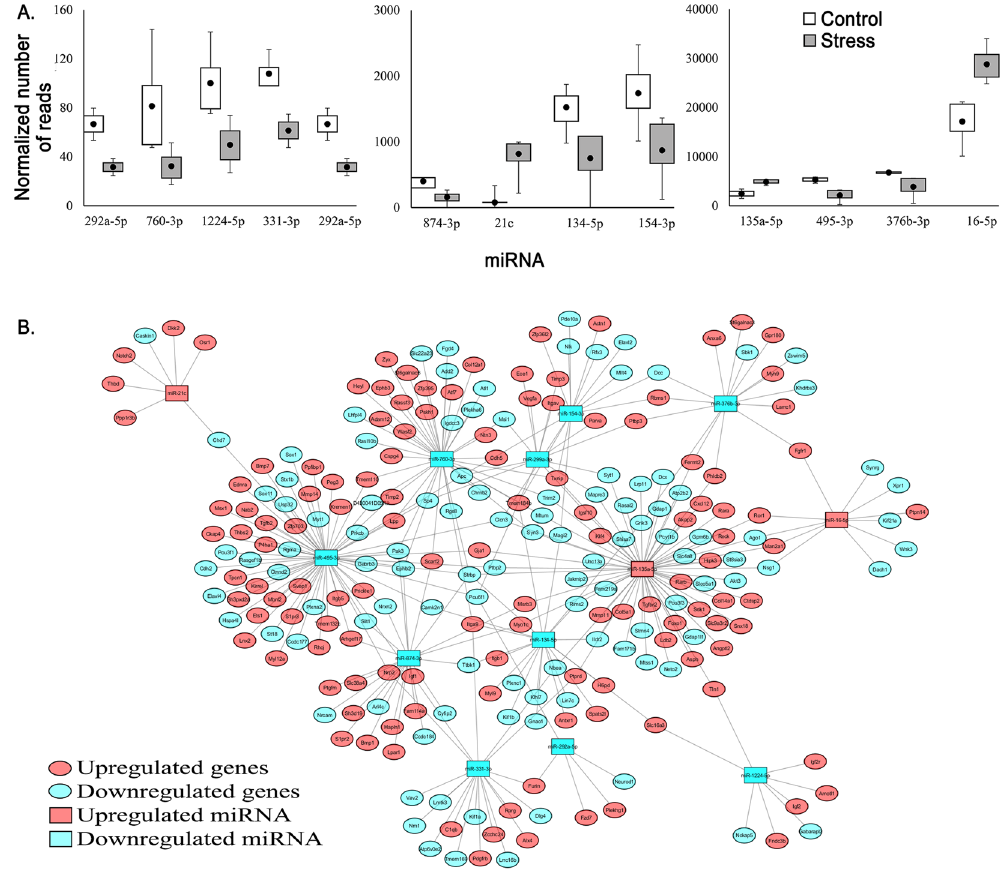
Figure 4. Expression level and targets of differentially expressed (DE) miRNA. ( A ) Number of reads mapping to the 13 DE miRNAs (p ≤ 0.05) that are predicted to target DE mRNA (p ≤ 0.05) in the wild-type (WT) embryos response to stress. ( B ) Cytoscape map illustrating the network of DE miRNA and their predicted